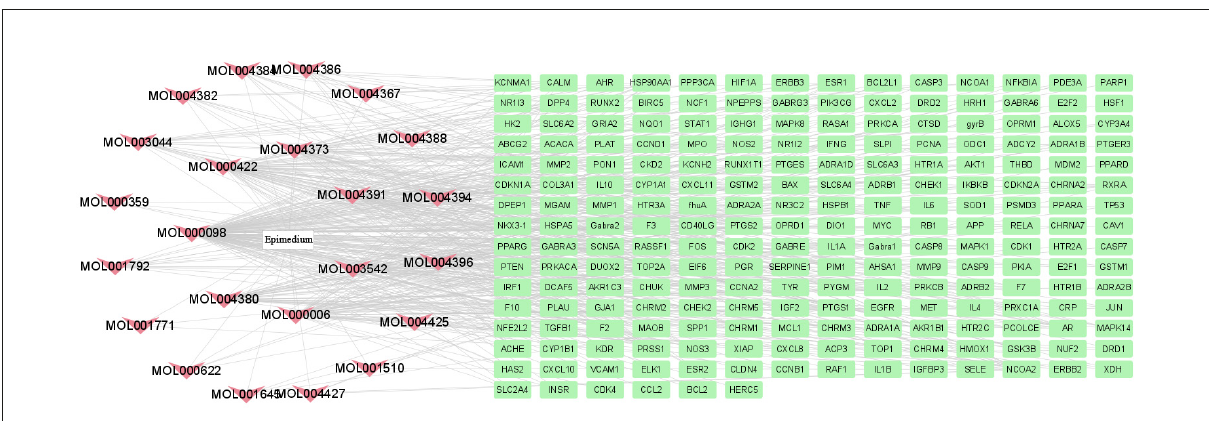
FIGURE1 Therapeutic targets of Epimedium. A total of 23 active compounds of Epimedium corresponding to 216 bioactive targets.